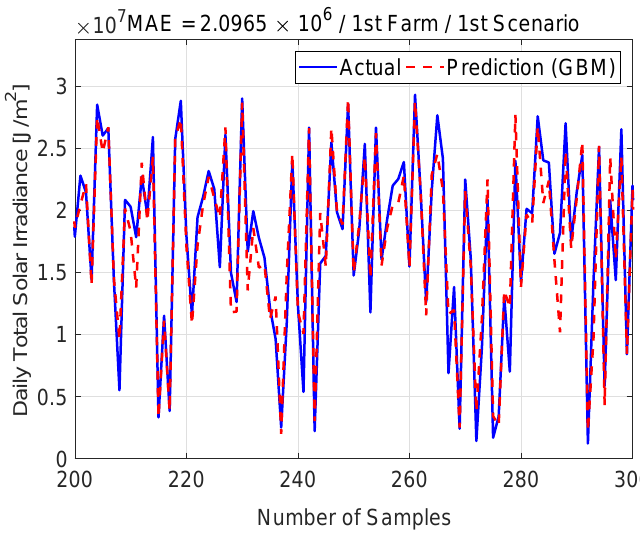
Figure 4. Actual target values for the test data and outputs from the GBM (gradient boosting machine) are compared. The red dotted line represents the outputs from the GBM, and the blue line represents the solar irradiation for